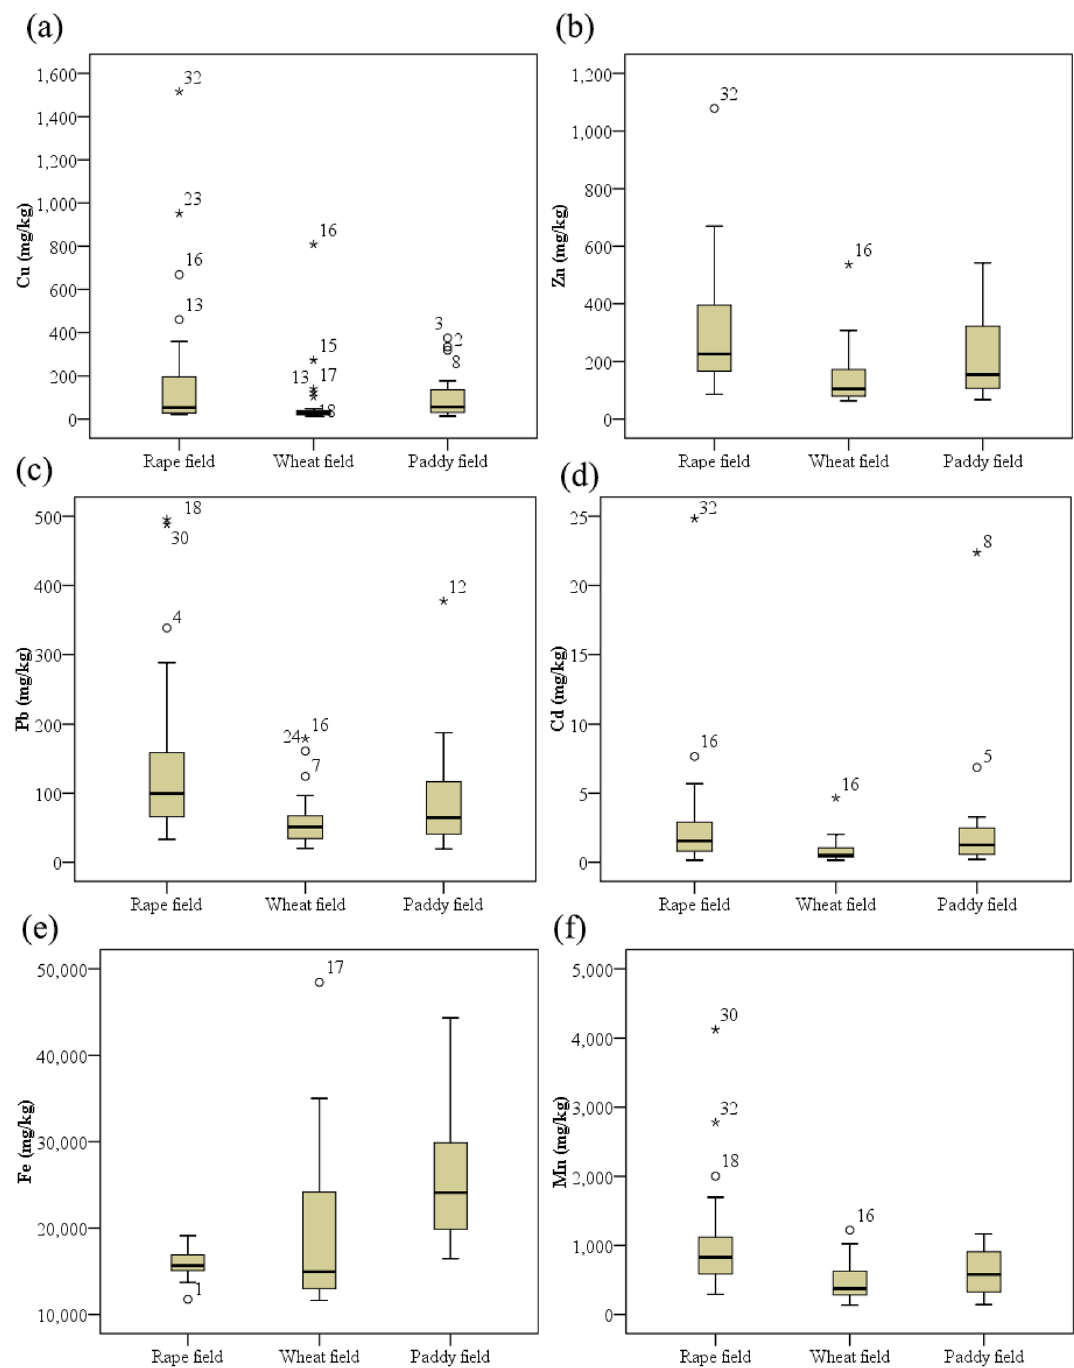
Figure 2. Descriptive statistics and distribution of heavy metals ((a) Cu, (b) Zn, (c) Pb, (d) Cd, (e) Fe, and (f) Mn) in soil samples collected in the study area. (Rape fields (n = 36); Wheat fields (n = 25); Paddy fields (n = 20), on dry weight